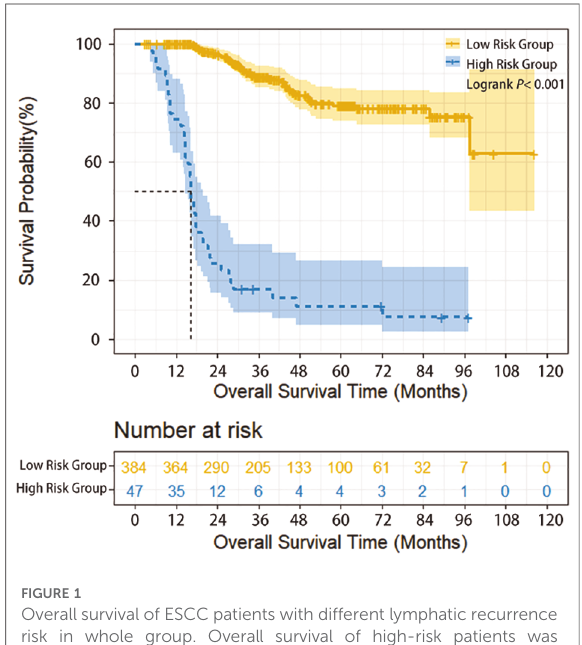
FIGURE 1 Overall survival of ESCC patients with different lymphatic recurrence risk in whole group. Overall survival of high-risk patients was signi fi cantly worse compared with low-risk patients in the whole group ( P <0.001).